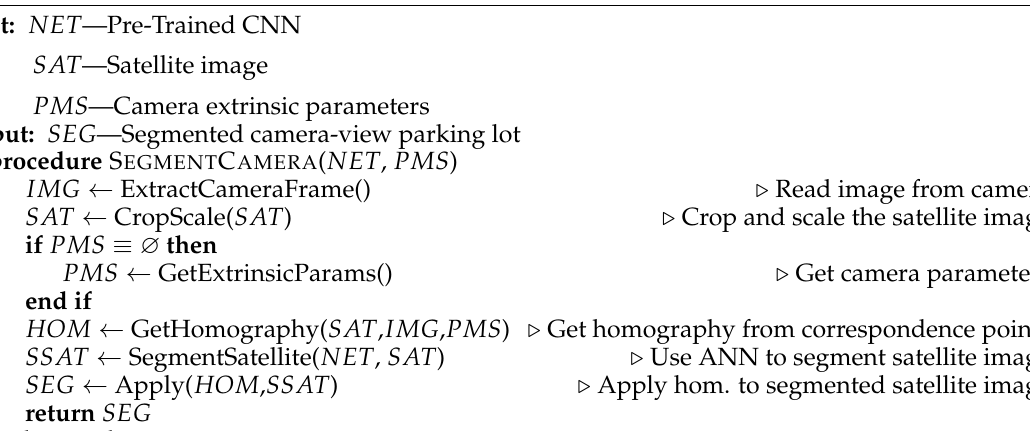
Algorithm 1 Parking Block Segmentation from a Surveillance Camera Perspective